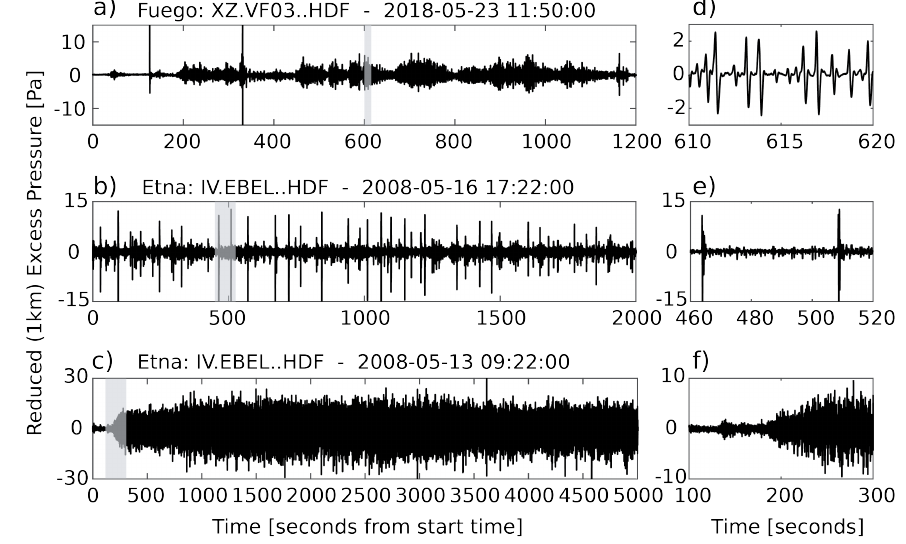
Figure 2. Extended duration infrasound waveforms: ( a ) Twenty minutes of very regular, pulse-like, degassing recorded at Fuego, Guatemala. This type of activity is often referred to as “chugging” and accompanied by audible degassing with a noise similar to that of a steam train. ( b ) Sequence of small Strombolian explosions recorded at Mt. Etna. This activity recorded in the summer of 2008, persisted for days. ( c ) Infrasound signature of a lava fountain recorded at Etna, Italy in May 2008. This episode lasted for several hours with relatively constant infrasonic amplitudes. ( d – f ) Enlargements of selected portions (shaded gray) of signals shown in ( a – c